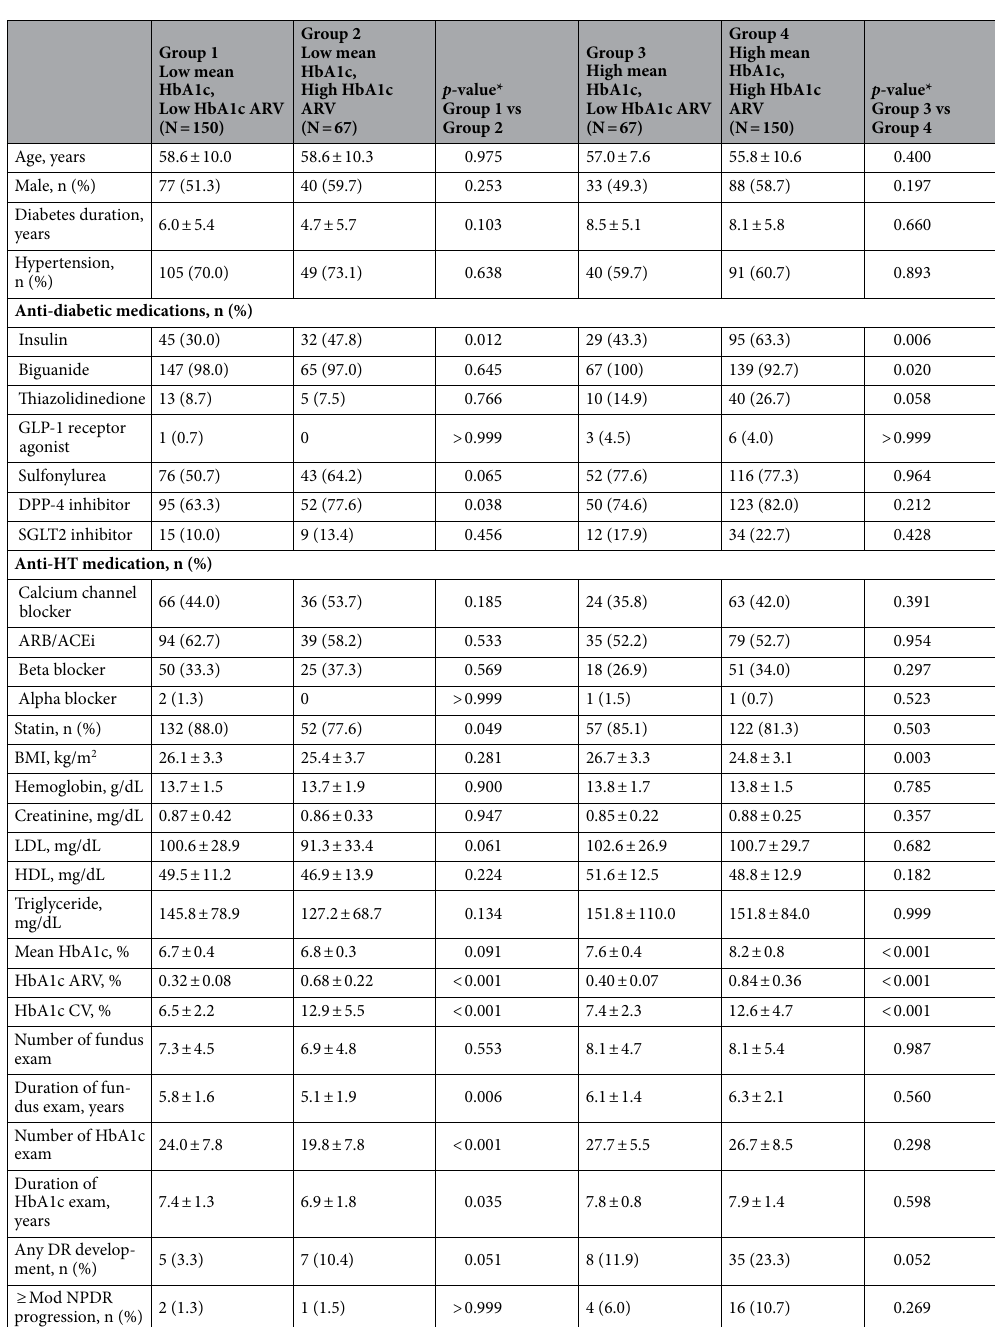
Table 2. Demographics and clinical characteristics of the subjects classified according to the mean HbA1c and the HbA1c variability. * Student’s t -test for continuous variables and chi-square or Fisher’s exact test for categorical variables. Abbreviations: Anti-HT, anti-hypertensive; ARB/ACEi, angiotensin receptor blocker/ angiotensin-converting enzyme inhibitor; ARV, average real variability; BMI, body mass index; CV, coefficient of variation; DPP4, dipeptidyl peptidase-4; DR, diabetic retinopathy; GLP-1, glucagon-like peptide-1; HbA1c, hemoglobin A1c; HDL, high-density lipoprotein; LDL, low-density lipoprotein; Mod NPDR, moderate nonproliferative diabetic retinopathy; SGLT2, sodium-glucose